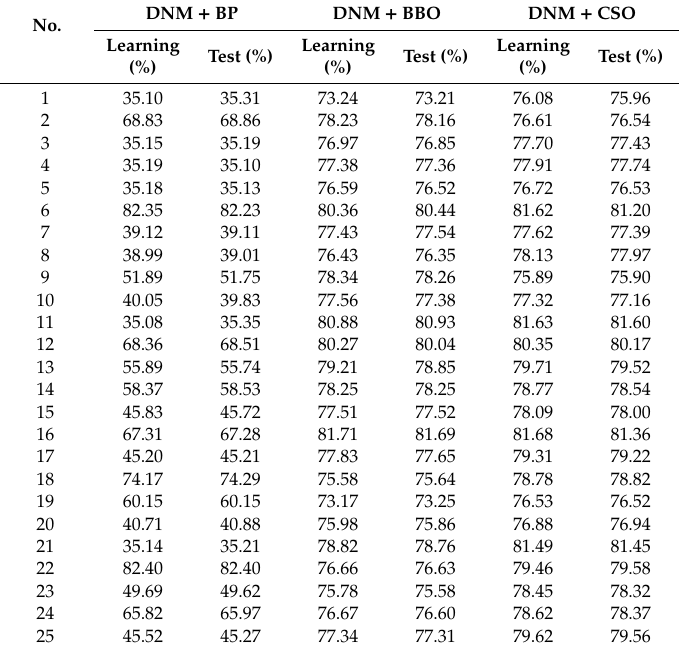
Table A1. Average accuracy of the learning and tests of each learning algorithm in F1.